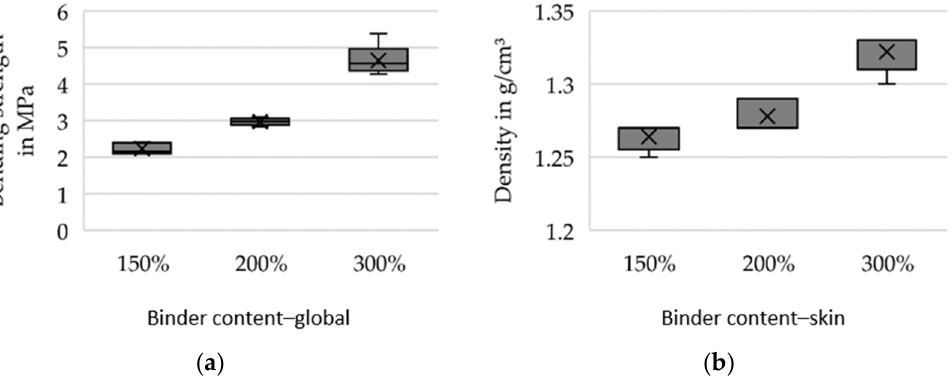
Figure 10. 3-point bending strength of specimens produced at varying binder contents. The binder content was increased ( a ) globally and ( b ) only in an outer skin of 5 mm. ( a ) globally and ( b ) only in an outer skin of 5